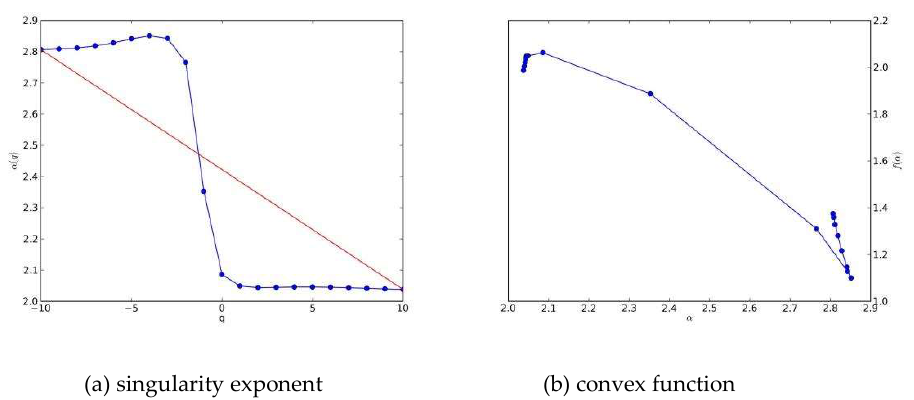
Figure 8. An abnormal phenomenon existed in the homogenized precipitation field of February 2015. ( a ) singularity exponent, ( b ) convex function.